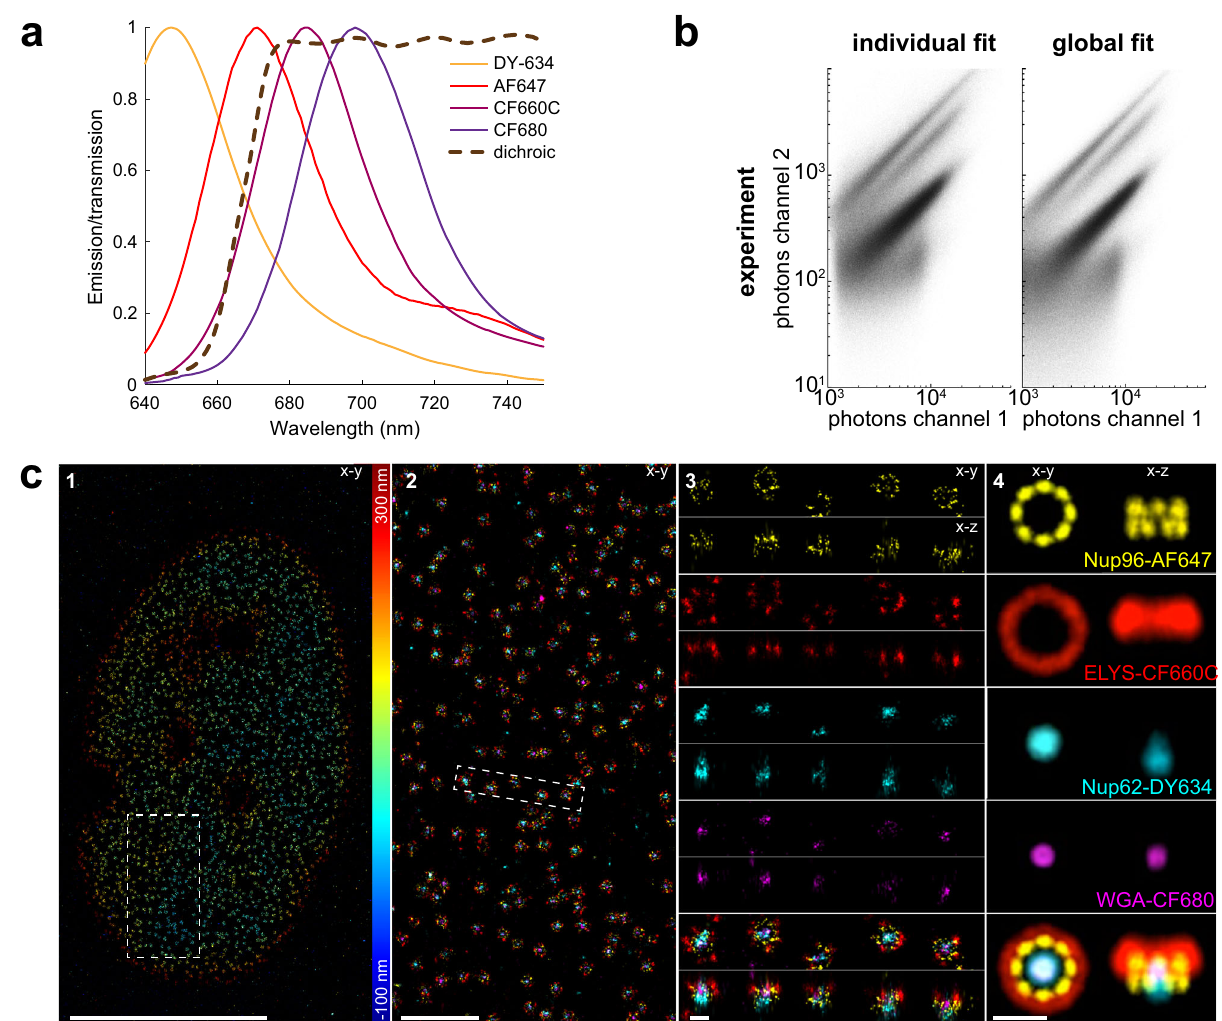
Fig. 4 Performance of globLoc on ratiometric multi-color data. a Emission spectra of DY-634, AF647, CF660C and CF680 and transmission pro fi le of the dichroic beamsplitter. The experimentally determined ratio of photons between dark and bright channels for these four dyes are 0.39, 0.21, 0.07 and 0.02. b Scatter plot of the fi tted transmitted versus re fl ected photons per localization in a typical 4 color experiment using global fi t and individual fi t separately. c 4 color 3D imaging of Nup62-DY634, Nup96-AF647, ELYS-CF660C and WGA-CF680 in the NPC using globLoc. c1 , Top view of bottom nuclear membrane. c2 , Zoomed image of the region indicated in d1. c3 , Top view and side view images of the region indicated in c2. c4 , Average of 200 NPC images by registering the Nup96 structures that we used as a reference. See Supplementary Movie 1. Representative results are shown from 3 experiments for ( c ). Scale bars 10 µ m ( c1 ), 1 µ m ( c2 ), 100 nm ( c3 - 4